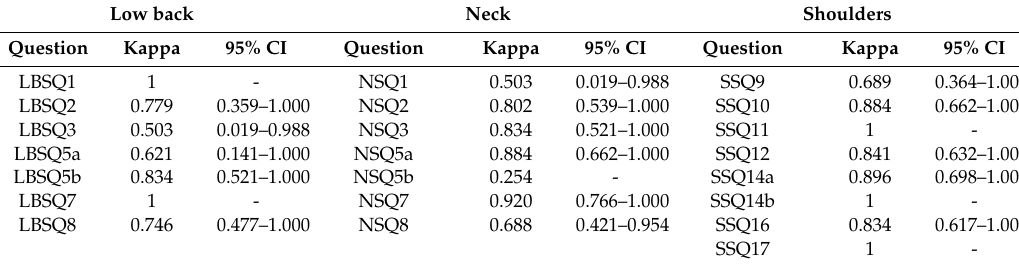
Table 2. The Kappa agreement correlation coefficient for each answer in the specific questionnaires ( n = 25). Low